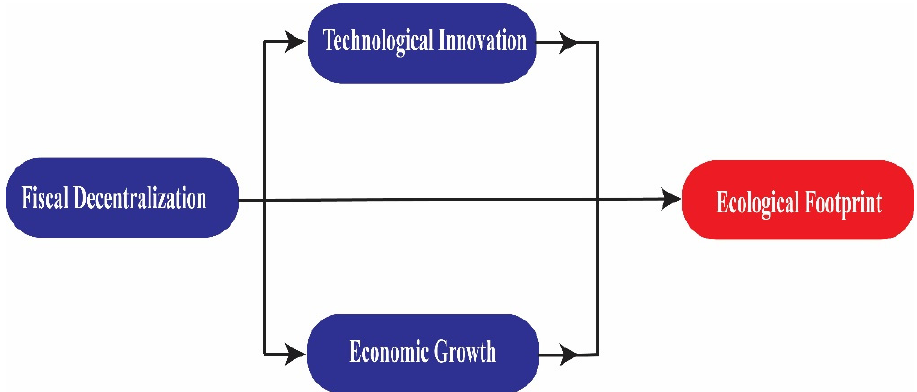
Figure 1. Flow chart for the conceptual framework.